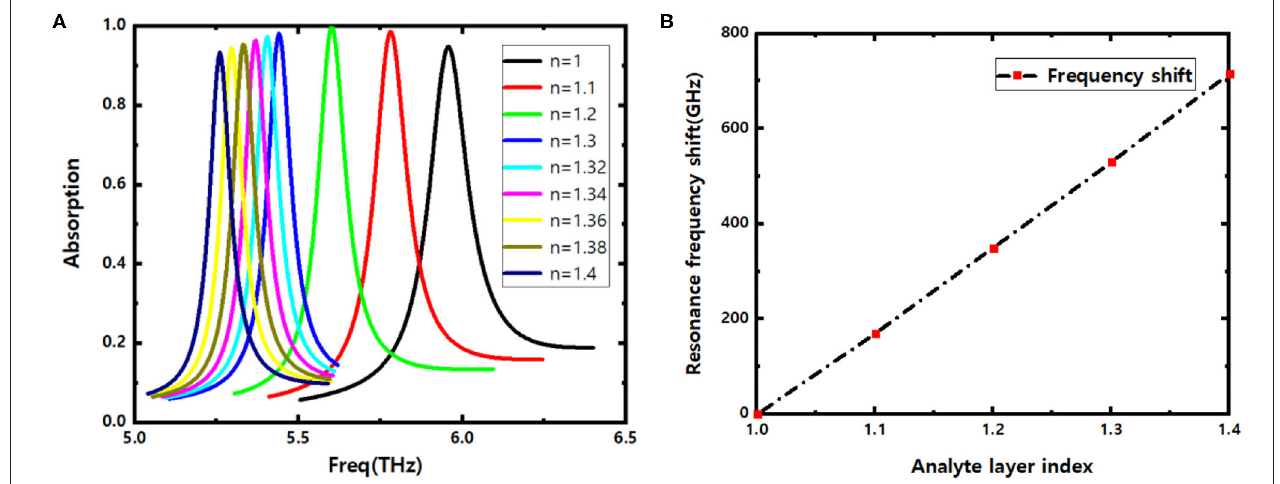
FIGURE 3 | (A) Offset of absorption curves vs. refractive index n of the analyte; (B) resonance frequency shift with the varying index of refraction n .